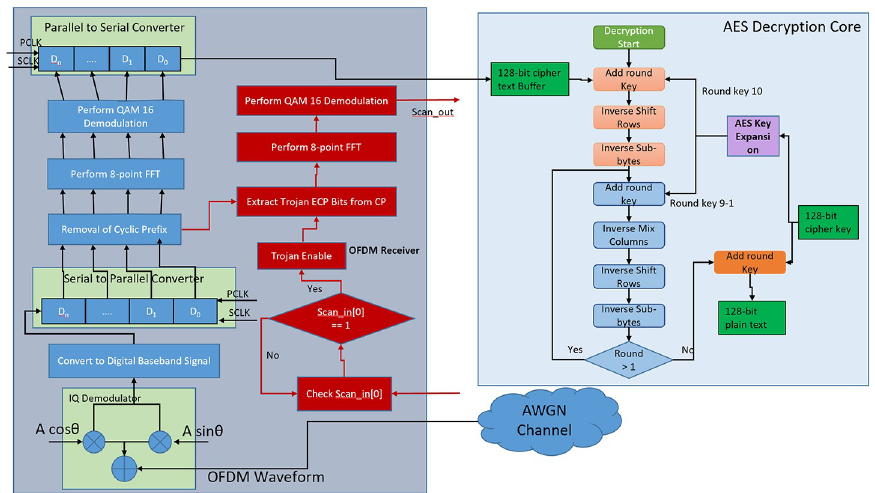
Fig 11. Flowchart of HT infested wireless receiver